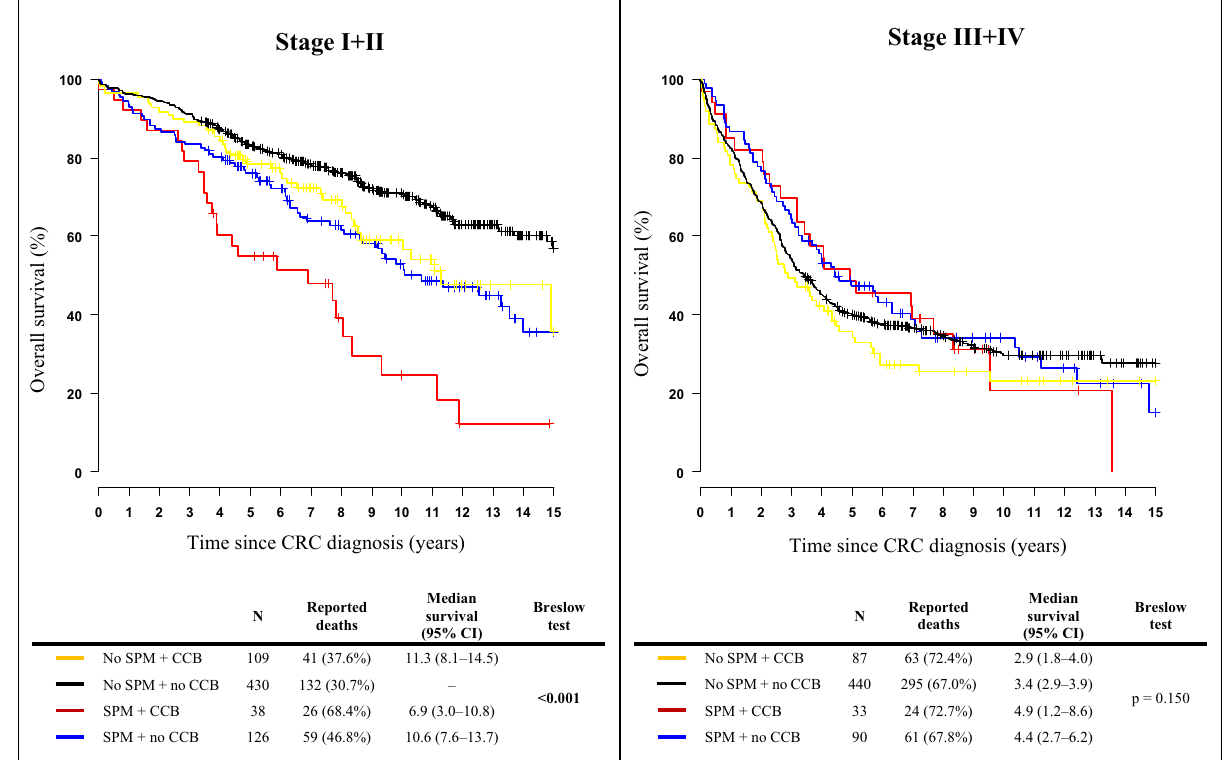
Figure 2. Kaplan–Meier curves of 15-year survival among colorectal cancer patients (C18–C20) stratified by the occurrence of second primary malignancy and the use of calcium channel blockers according to clinical stages. SPM second primary malignancy, CCB calcium channel blocker, CI confidence